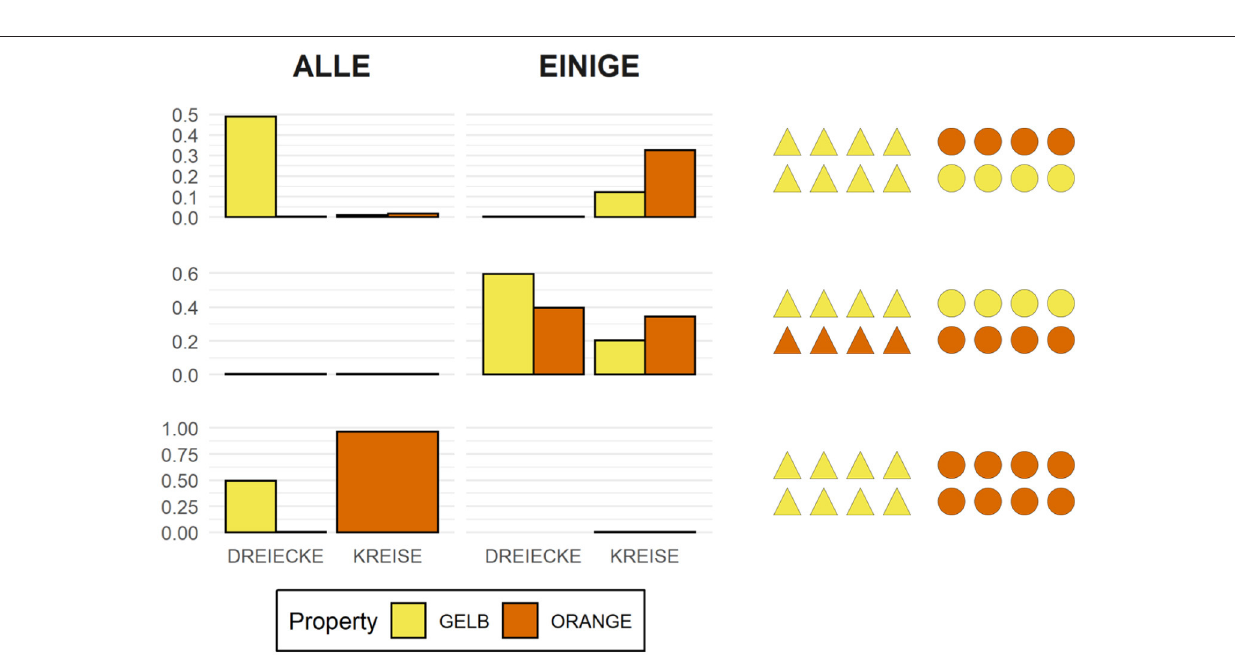
FIGURE 3 | Proportion of production choices by picture type. The written labels indicate the type of expression selected by participants, which included a quantifier ( alle vs. einige ), a shape term ( Dreiecke vs. Kreise ), and a property term ( gelb vs. orange ). The left column shows descriptions containing the quantifier alle , while the right column shows descriptions containing the quantifier einige